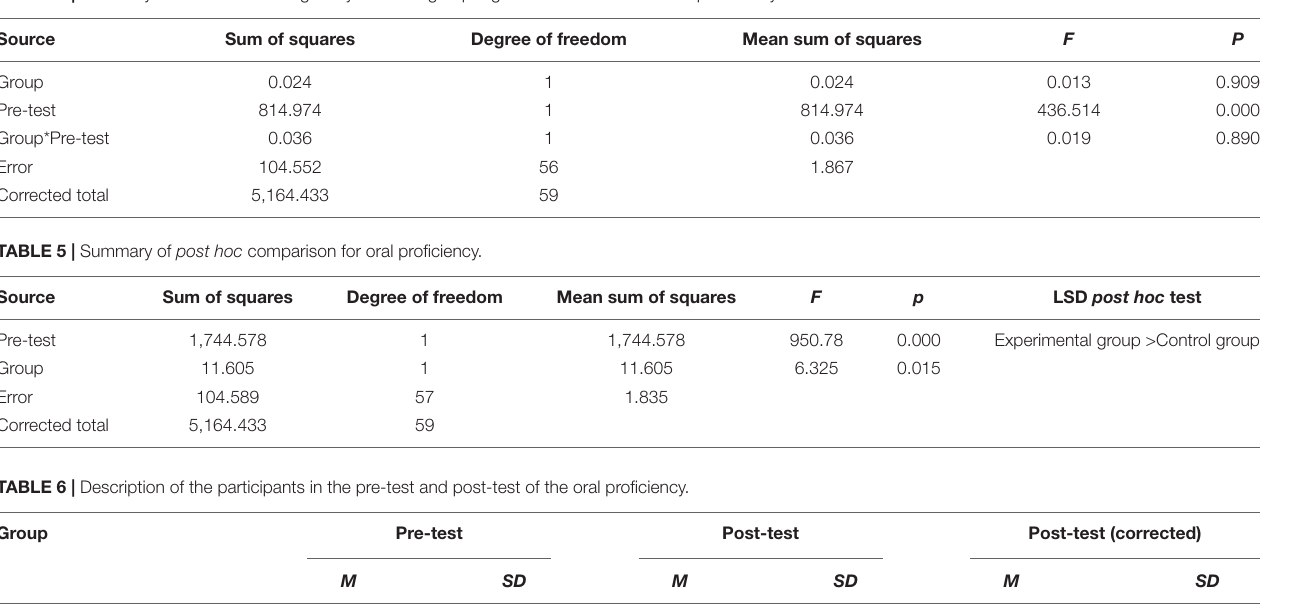
TABLE 4 | Summary of the test of homogeneity of within-group regression coefficient for oral proficiency.